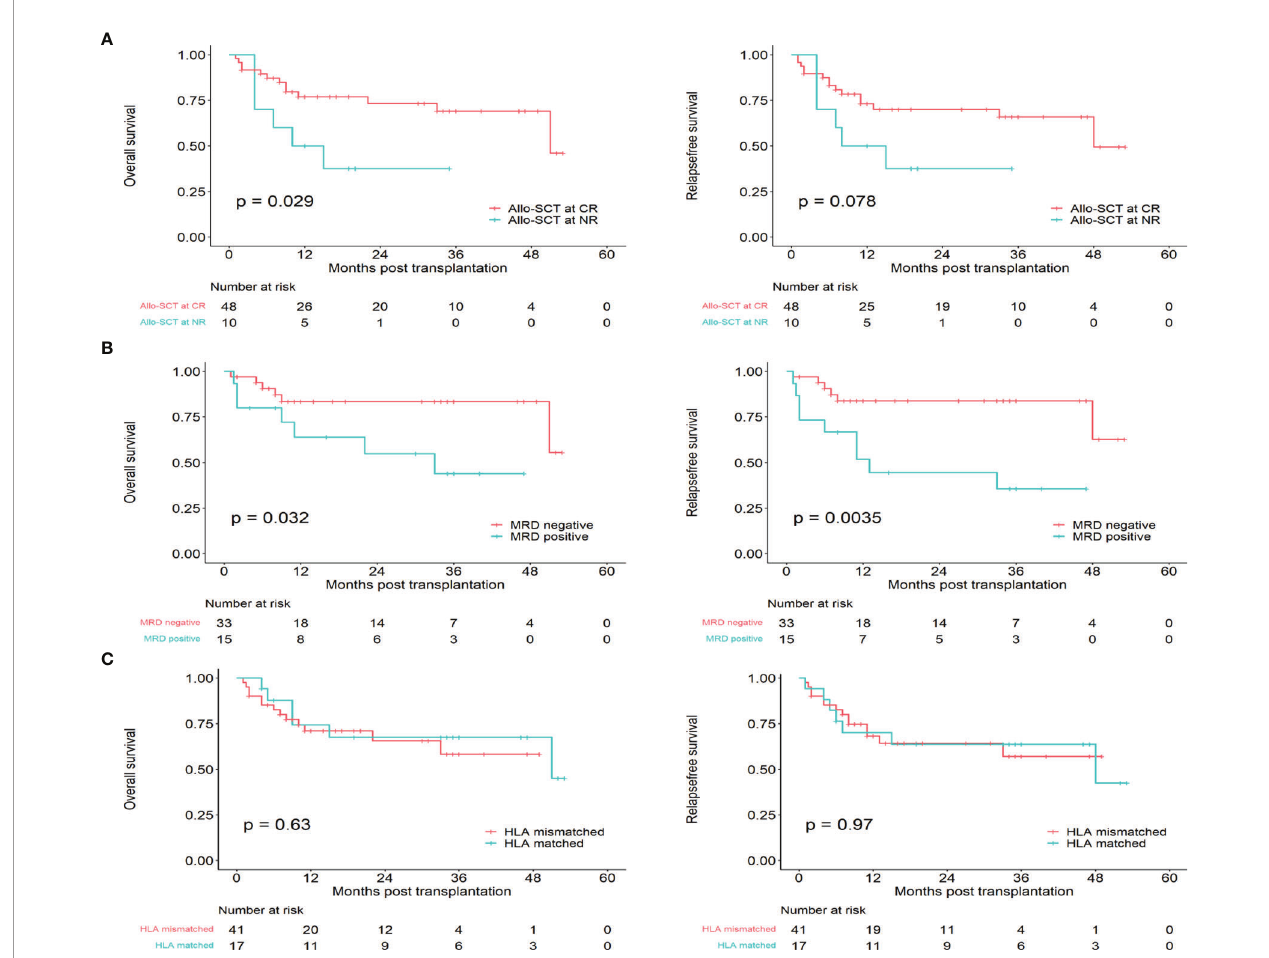
FIGURE 4 | The prognosis of Early T-cell precursor leukemia/lymphoma with transplantation. (A) Overall survival and relapse free survival for allo-SCT at CR and allo-SCT at NR. (B) Overall survival and relapse free survival for patients with CR in MRD positive and MRD negative. (C) Overall survival and relapse free survival for HLA-matched and